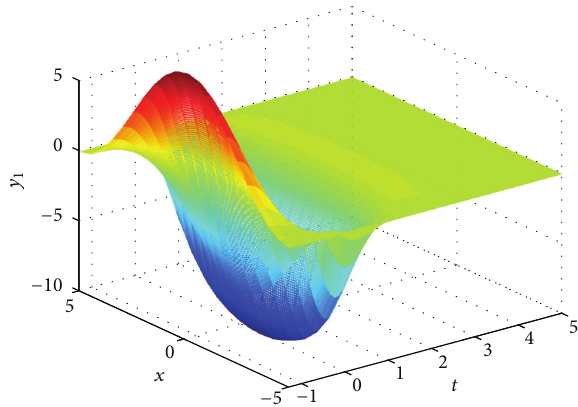
Figure 1: The dynamical behavior of the subsystem 𝑦 1 of system (36).